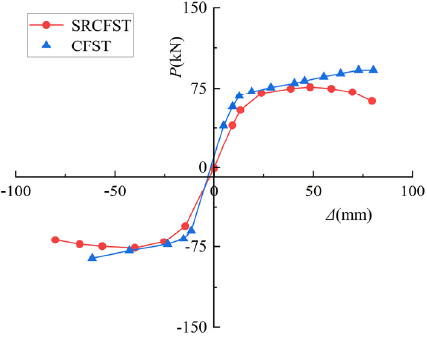
Figure 16. P - Δ skeleton curves. Table 4. Comparison of ductility coefficients.